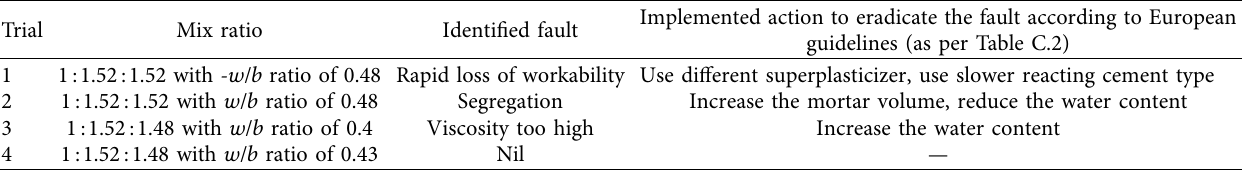
Table 1: Trial and error method to obtain SCC.